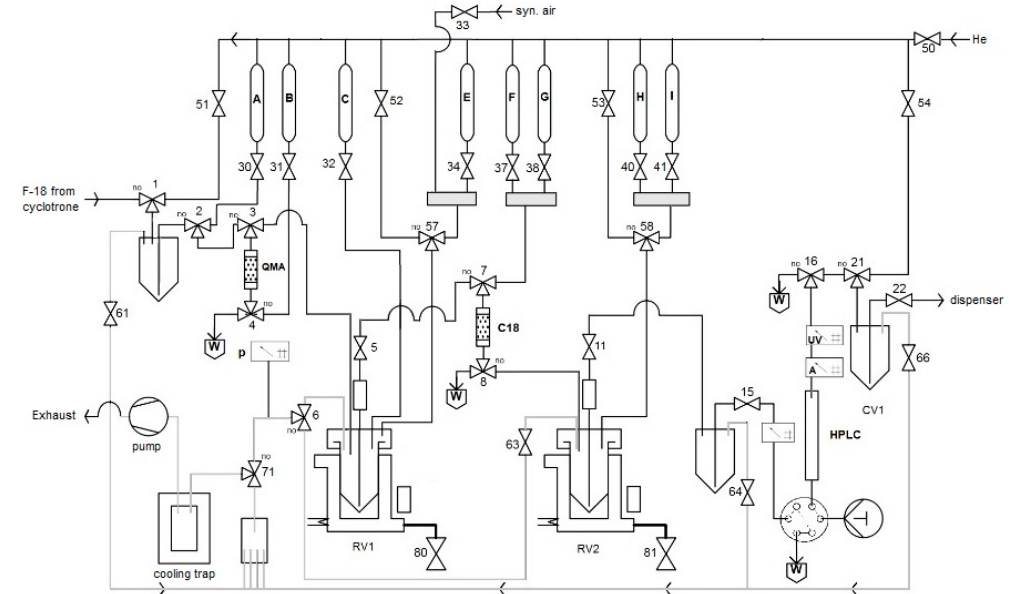
Figure 15. Process flow diagram (PFD) for the automated radiosynthesis of [ 18 F]OMFD, 2-[ 18 F]FTyr, 6-[ 18 F]FMT and 6-[ 18 F]FDOPA. A: MeOH (2 mL); B: Et 4 NOTf (3.1 mg, 11 µ mol) in MeOH (700 µ